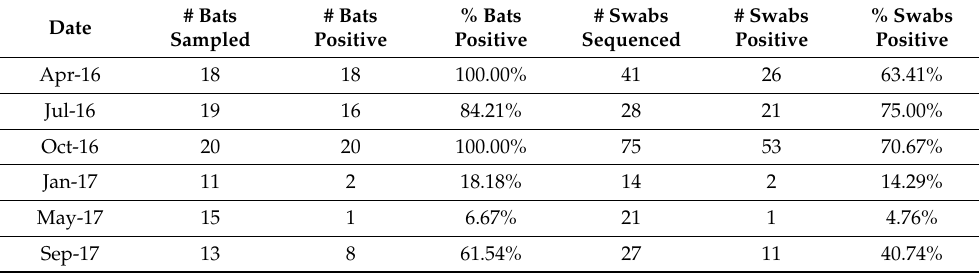
Figure 1. Coverage of deduplicated reads from bat 7633EDB body swab that mapped to DbPV scaffolded genome, with estimated genes depicted below the x-axis. Gaps between contigs exist where read count is 0. Table 1. Prevalence of novel bat mumps virus at each time point.